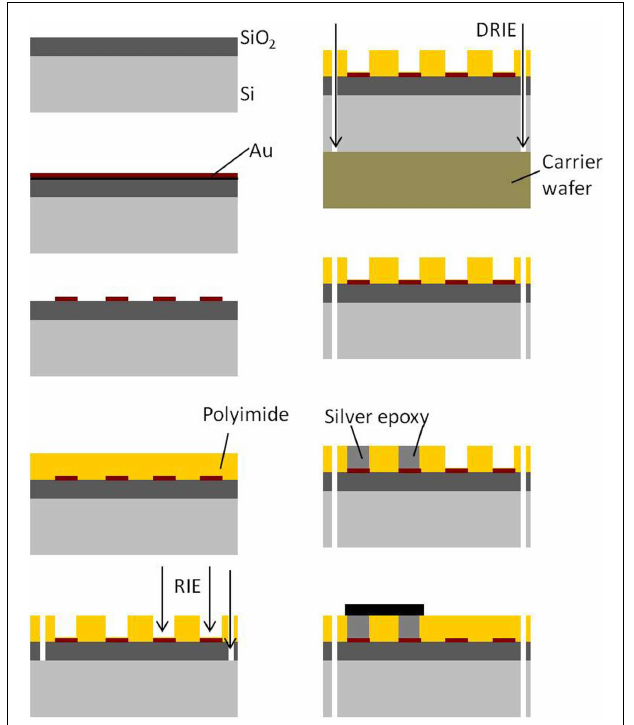
FIGURE 3 | Process flow for rigid electronics and connector module .